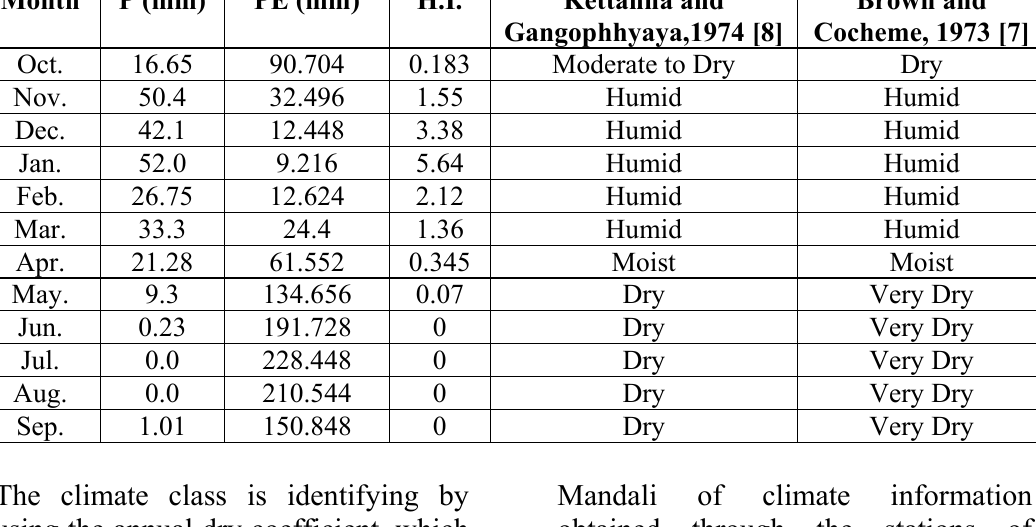
Table 5: Evaluation of monthly climate averages in the study area according to the (Brown and Cocheme, 1973)[8] and (Kettanha and Gangophhyaya,